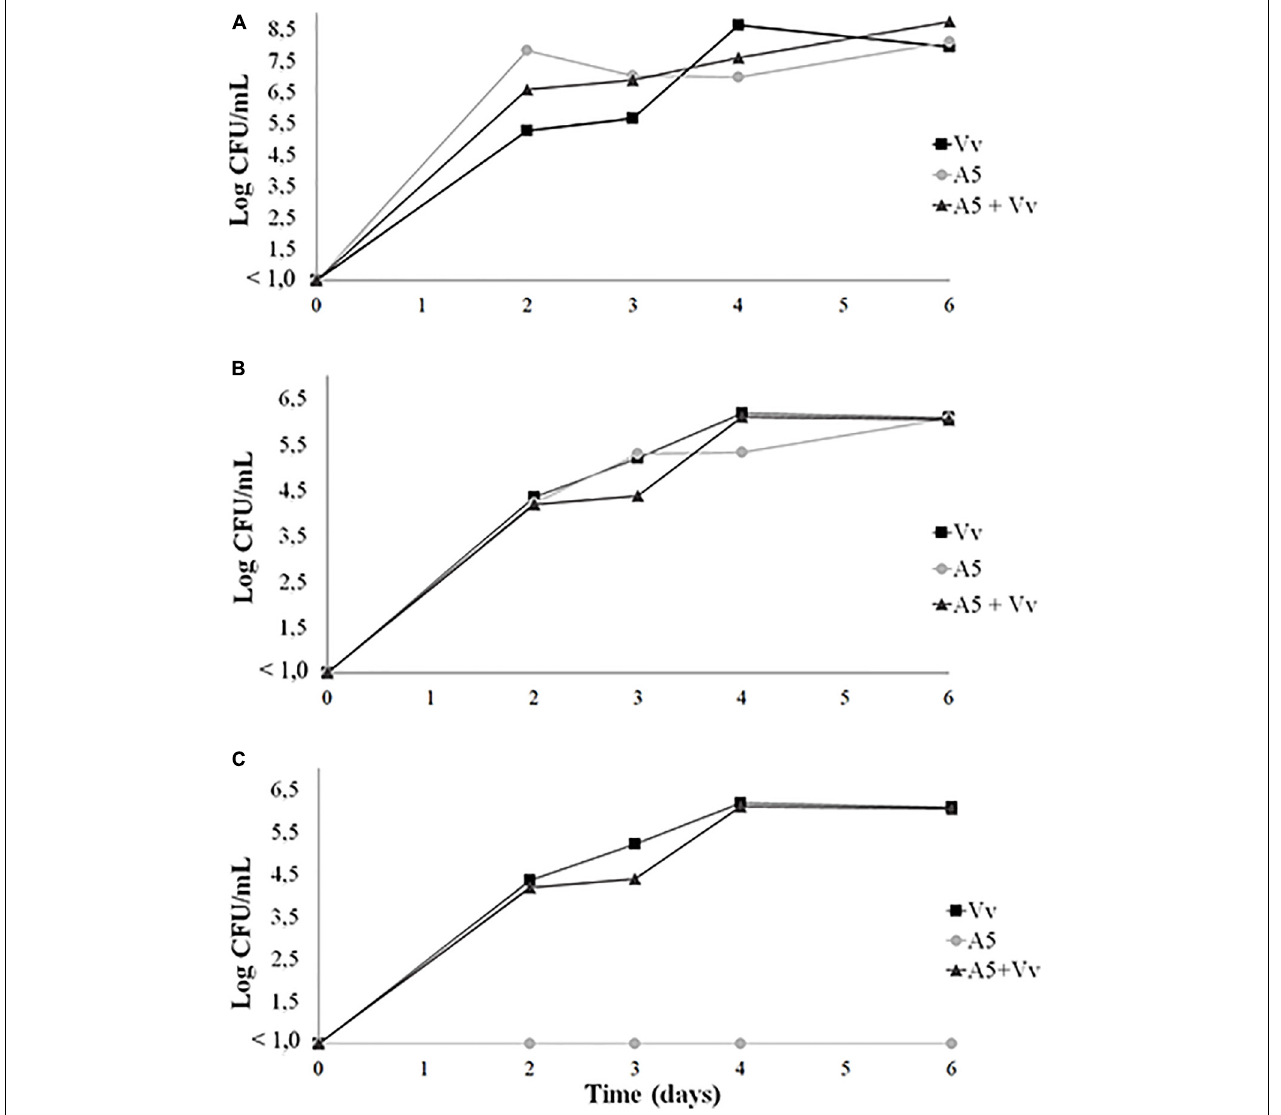
FIGURE 3 | Total aerobic bacteria (A) , total vibrio (B) , and Vibrio vulnificus (C) levels in coculture experiments in autoclaved seawater. Seawater from the Vv treatment was inoculated with V. vulnificus only ( (cid:4) ), seawater from the A5 treatment was inoculated with A5 only ( • ), seawater from the A5 + Vv treatment was co-inoculated with A5 and V. vulnificus ( (cid:78) ). The absence of colonies is represented as below the limit of detection (LOD) ( < 1.0 log